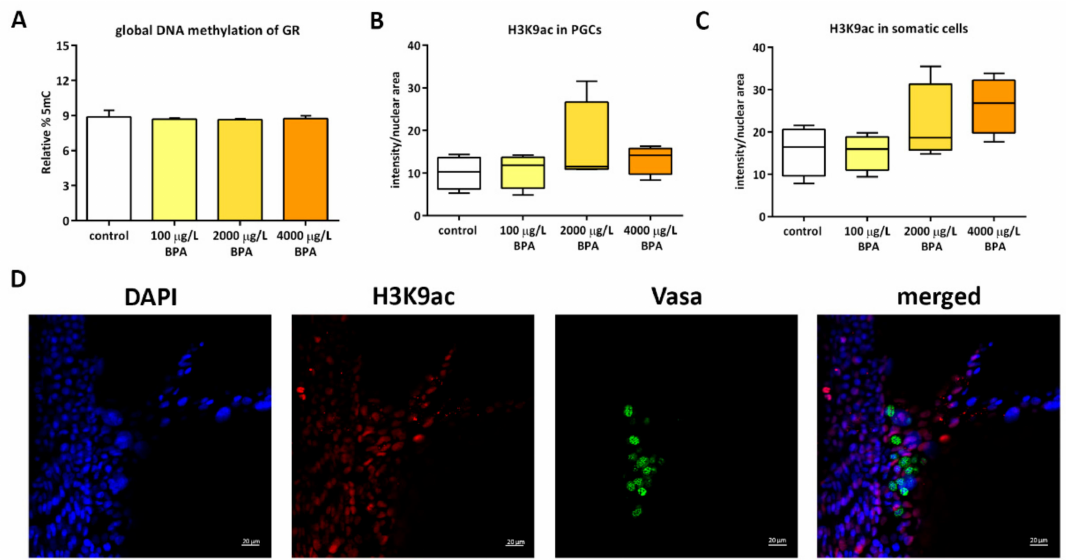
Figure 2. Epigenetic profile of PGCs and their somatic surrounding cells. ( A ) Quantification of 5 mC by UPLC-MS in DNA of genital ridges (GR) from control and BPA-treated embryos. Bars represent the percentage of 5mC relative to C in 3 pools of 20 genital ridges per treatment ( n = 3). Quantification of H3K9ac by whole mount immunofluorescence in ( B ) germ cells and ( C ) somatic cells of 24 hpf control and BPA-exposed embryos. Boxes represent the median plus maximum and minimum of H3K9ac intensity relative to nuclear area in 4 independent experiments ( n = 4). ( D ) confocal images of double immunostaining in genital ridges of 24 hpf control embryos. H3K9ac was labelled with AlexaFluor ® 568 (red fluorescence), Vasa protein within PGCs was labelled with AlexaFluor ® 488 (green fluorescence) and nuclei were stained with DAPI (in blue); scale bar 20 µ